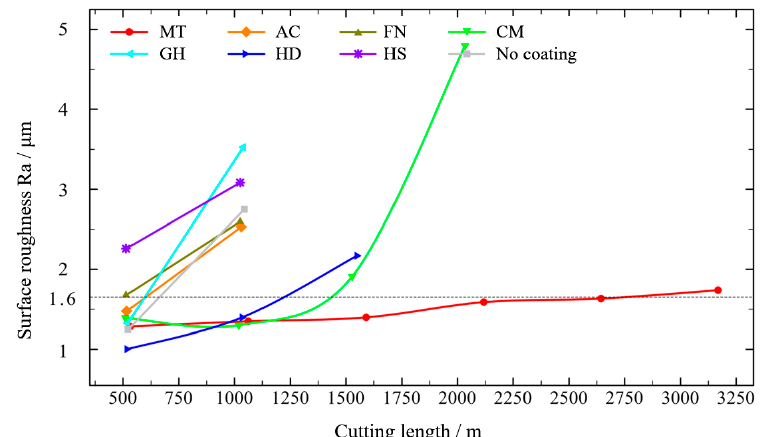
Figure 16. Surface roughness of the workpiece with different coatings at high speed. The flank wear values after cutting with different coatings are shown in Figure 17.